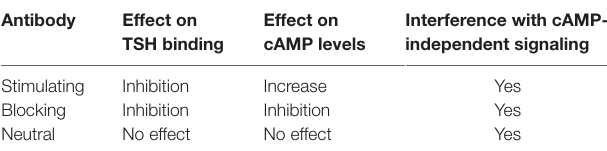
TABLe 1 | Summary of the functional characteristics of